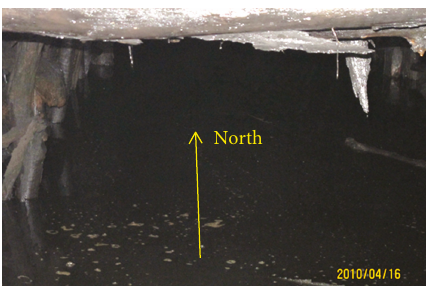
Figure 10: The accumulated water in the No.1 abandoned tunnel.